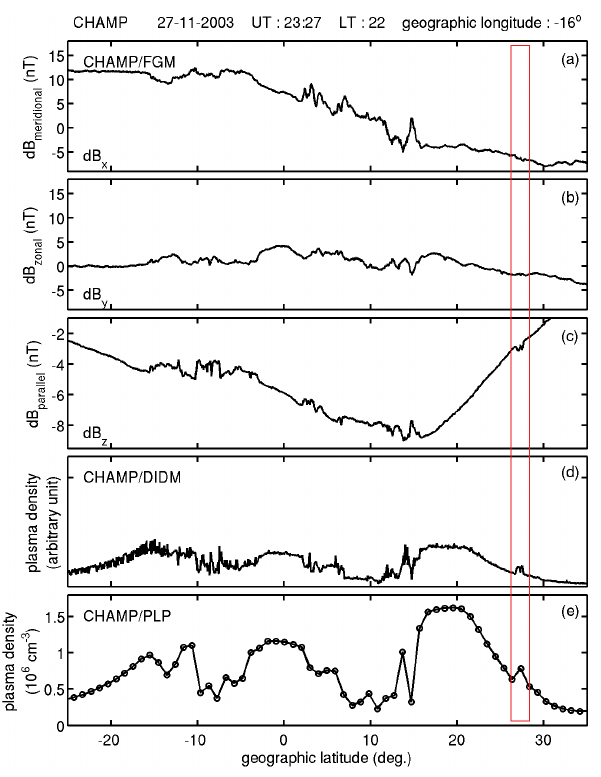
Fig. 2. Another blob example in the same format (with different scales) as in Fig. 1.